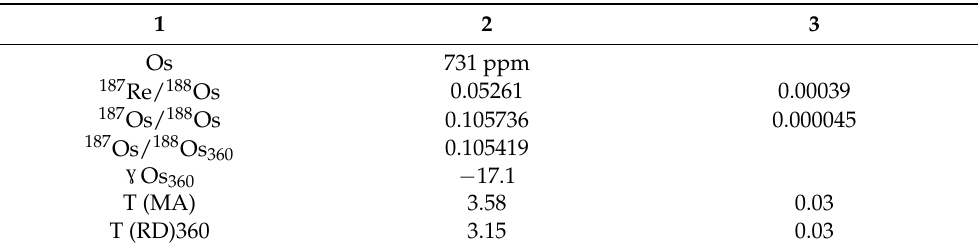
Table 4. Re-Os isotope data for sulfide. 1—characteristics and modeling method; 2—data and estimated age;